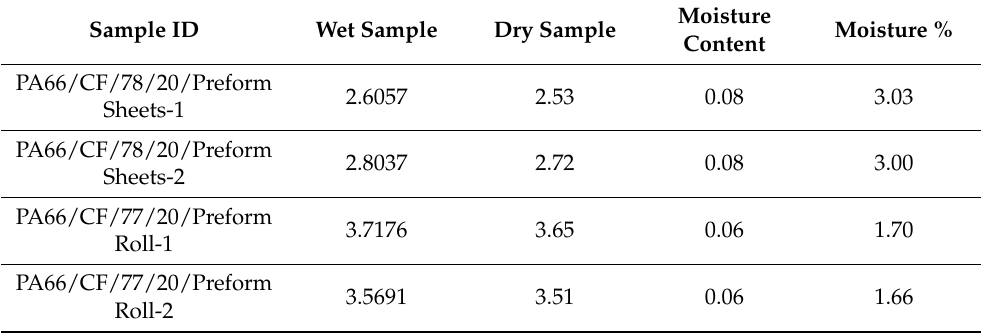
Table 2. Moisture analysis of WL PA66-CF ‘sheet’ and ‘roll’